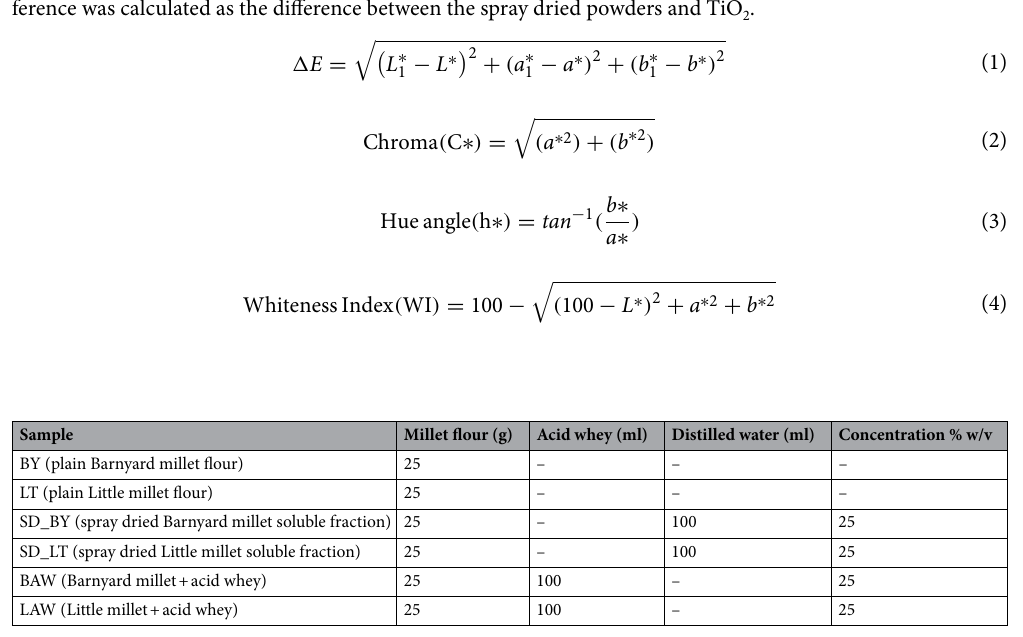
Table 1. AWM formulation and sample code description.